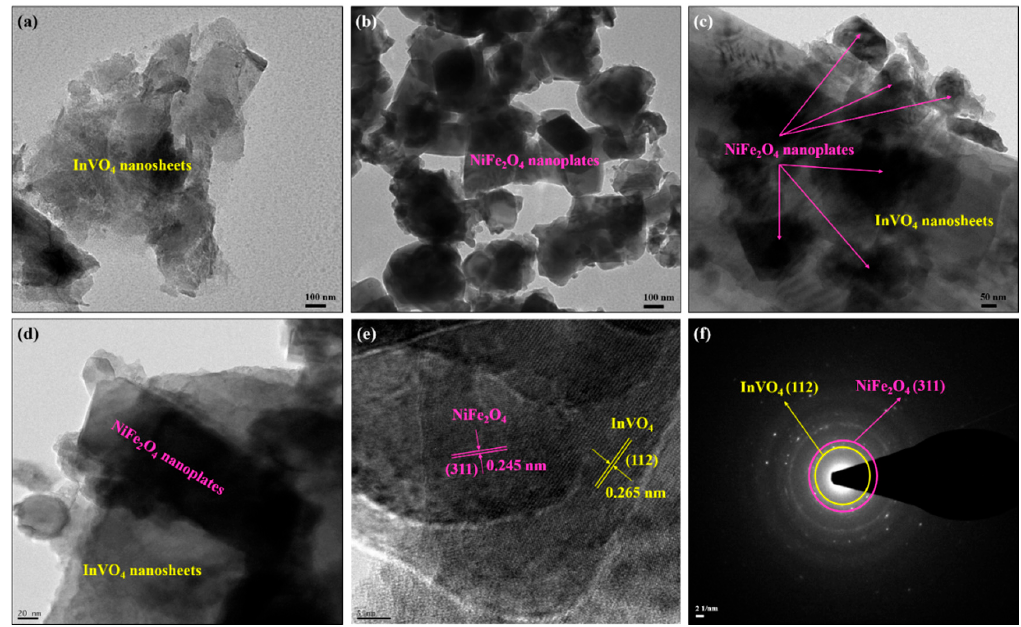
Figure 3. Transmission electron microscopy (TEM) images of ( a ) InVO 4 , ( b ) NiFe 2 O 4 , and ( c ) IVNF- 5.0; ( d ) high-resolution TEM image; ( e ) lattice fringes and ( f ) selected area electron diffraction patterns of the IVNF-5.0 nanocomposite.